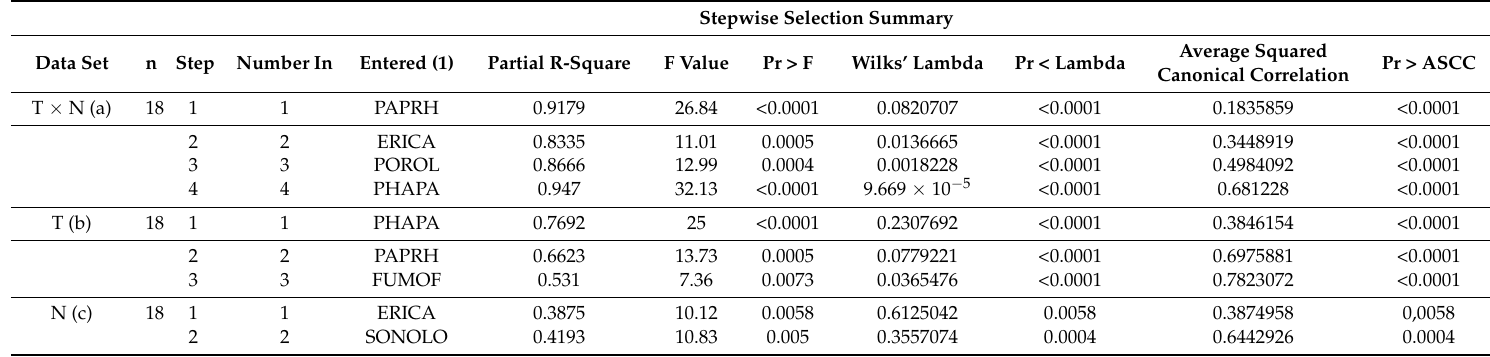
Table 4. Results of Stepwise Discriminant Analysis carried out on the weed species of the 0.20 to 0.40 m layer, considering both the different managements separately (Tillage (b)—and Nitrogen (c)) and their interaction (Tillage × Nitrogen